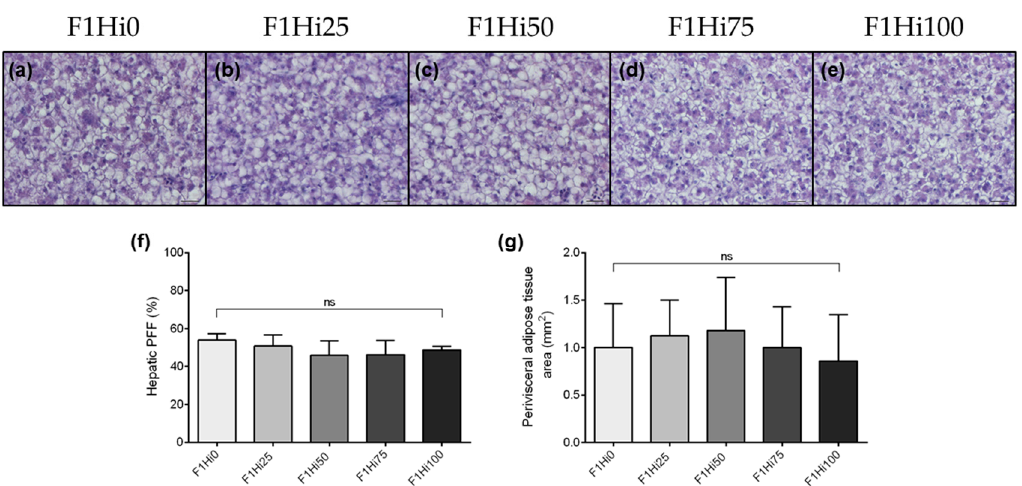
Figure 3. ( a – e ) Example of hepatic parenchima histomorphology, ( f ) percentage of fat fraction (PFF) in liver tissue and ( g ) perivisceral adipose tissue area (mm 2 ) of F1 zebrafish larvae fed diets including 0%, 25%, 50%, 75% and 100% of BSF prepupae meal respect to FM (F1Hi0, F1Hi25, F1Hi50, F1Hi75 and F1Hi100 groups). Scale bars: 20 µ m. For PFF and perivisceral adipose tissue area, values are shown as mean ± standard deviation ( n = 15). ns: no significant differences.